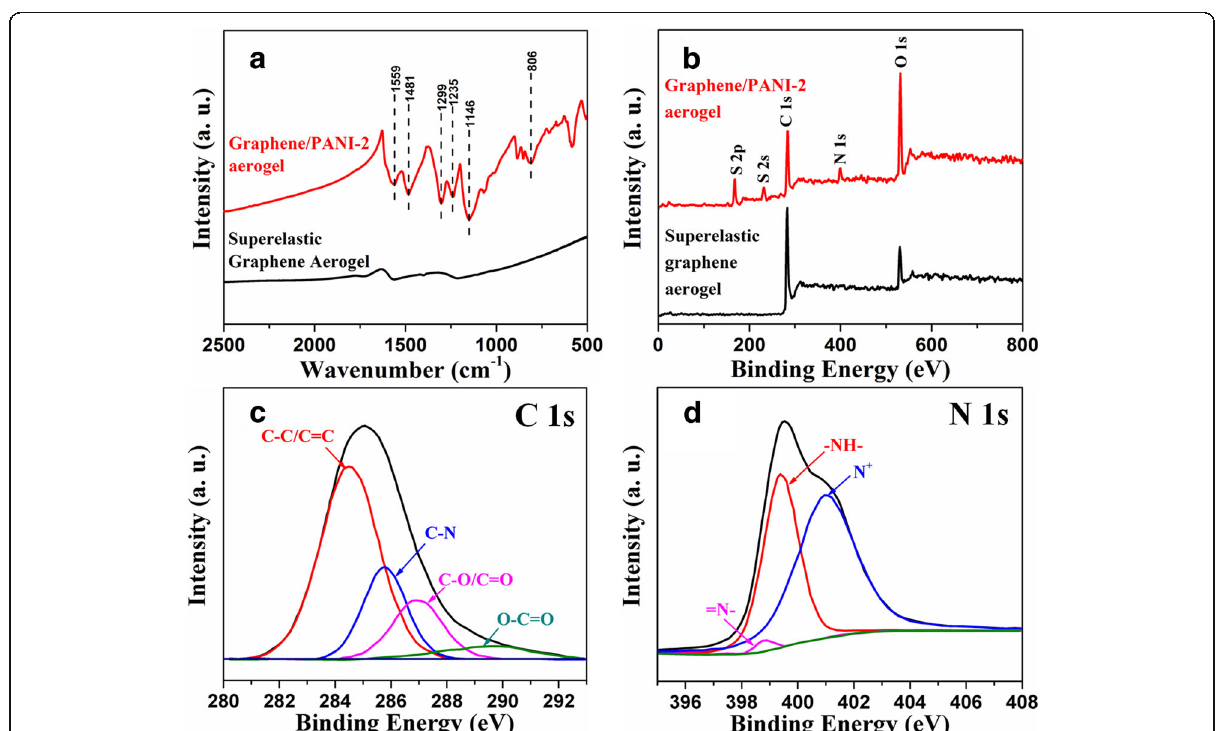
Fig. 4 a FTIR spectra and b XPS spectra of superelastic graphene aerogel and graphene/PANI-2 aerogel. c C 1 s and d N 1s spectra of graphene/PANI-2